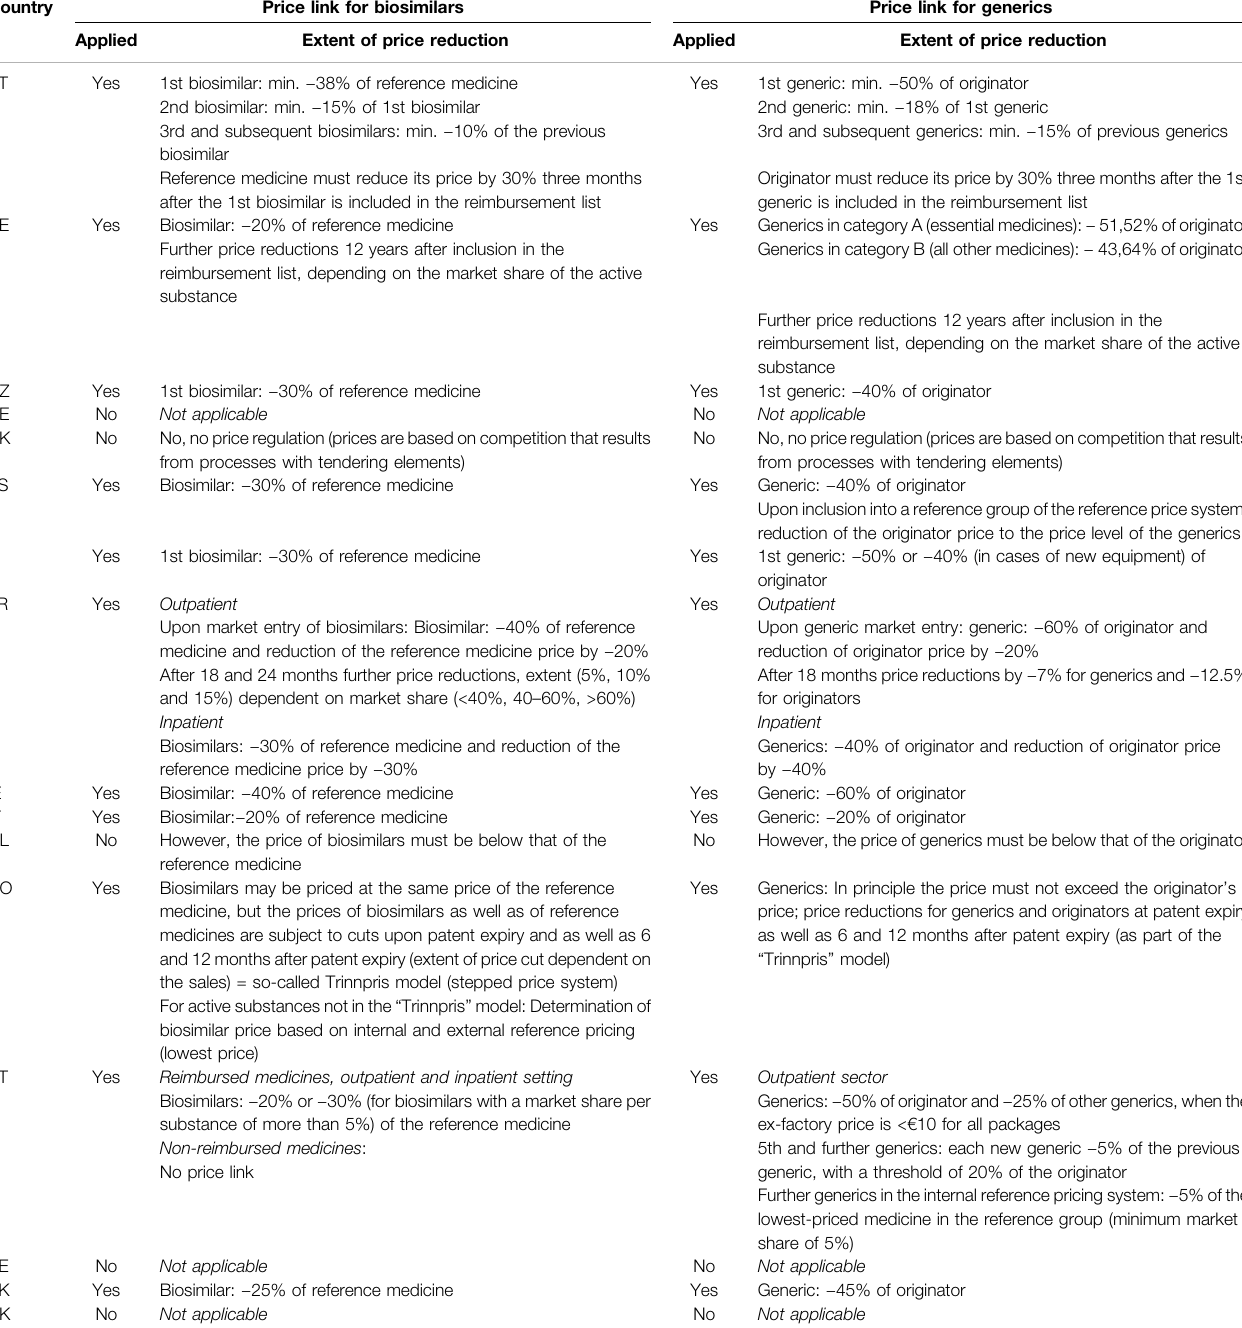
TABLE 2 | Price-link policies for biosimilar medicines compared to generics as provided in national legislation. Country Price link for biosimilars Price link for generics Applied Extent of price reduction Applied Extent of price